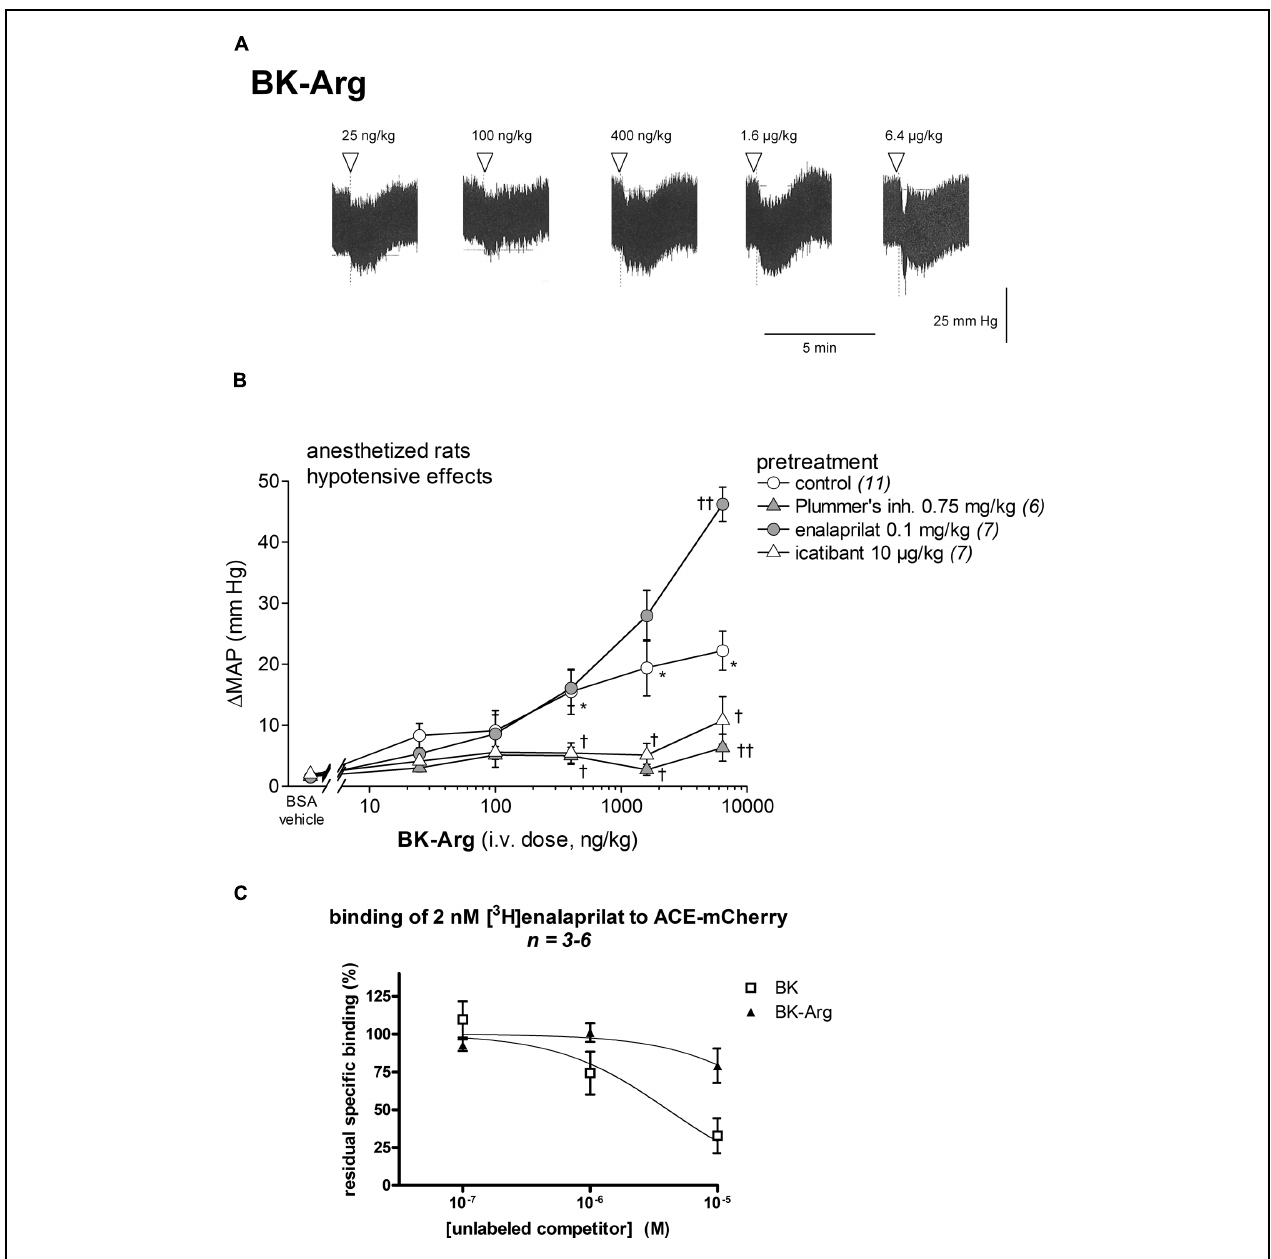
FIGURE 5 | Hypotensive responses to i.v. bolus injections of increasing doses of BK-Arg in anesthetized rats. (A) Representative traces showing the dose-response effect of BK-Arg on systemic blood pressure. Doses of BK-Arg are in ng/kg. Abscissa: time; ordinate: arterial pressure (mm Hg). (B) Effect of i.v. pretreatment with enalaprilat (0.1 mg/kg), icatibant (10 µ g/kg) or Plummer’s inhibitor (0.75 mg/kg) on the maximal hypotensive response to i.v. injections of increasing doses of BK-Arg. The pretreatment with the peptidase inhibitors was given as bolus 15 min before the starting injections of BK-Arg. The number of determination in different animals is given between parentheses for control and each inhibitor. Abscissa: dose (ng/kg); ordinate: fall of (MAP; mm Hg). Values are means ± SEM. (C) Competition of [ 3 H]enalaprilat (2 nM) binding to recombinant human somatic ACE by BK-Arg and BK. Results are expressed as the residual specific binding (means ± SEM of n duplicate determinations). ∗ P < 0.01 control group values compared with vehicle value; † P < 0.05; †† P < 0.01 pretreated group values compared with the control group values (Dunnett’s